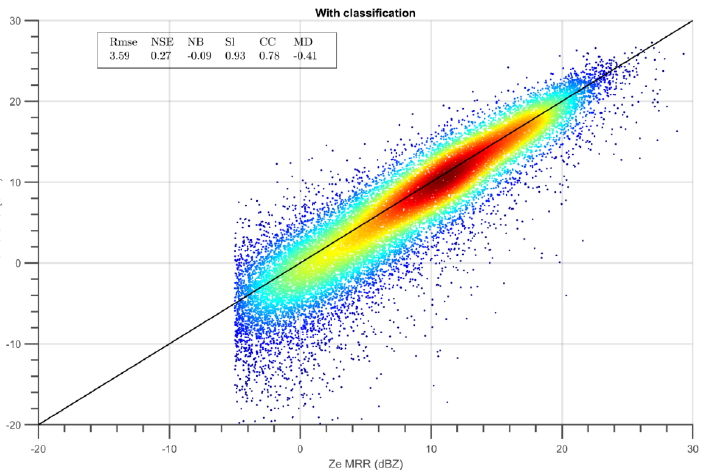
Figure 8. Density scatter plots for 1-min radar and disdrometer data in terms of radar reflectivity after hydrometeor classification, as described in the text. Dots are colored based on data density, ranging from dark red (high density) to dark blue (low density). Black line represents the bisecting line. Merit factors of the comparison are reported in the text box.